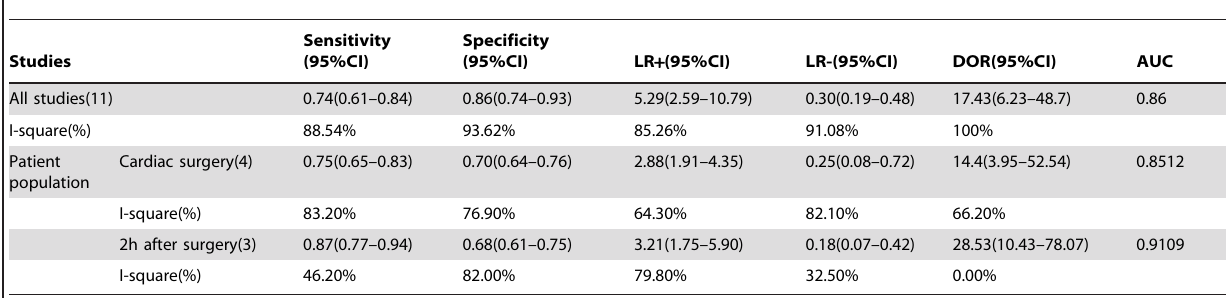
Abbreviations: AUC, area under the receiver operating characteristic curve; CI, confidence interval; + LR, positive likelihood ratio; -LR, negative likelihood ratio; DOR, diagnositic odds